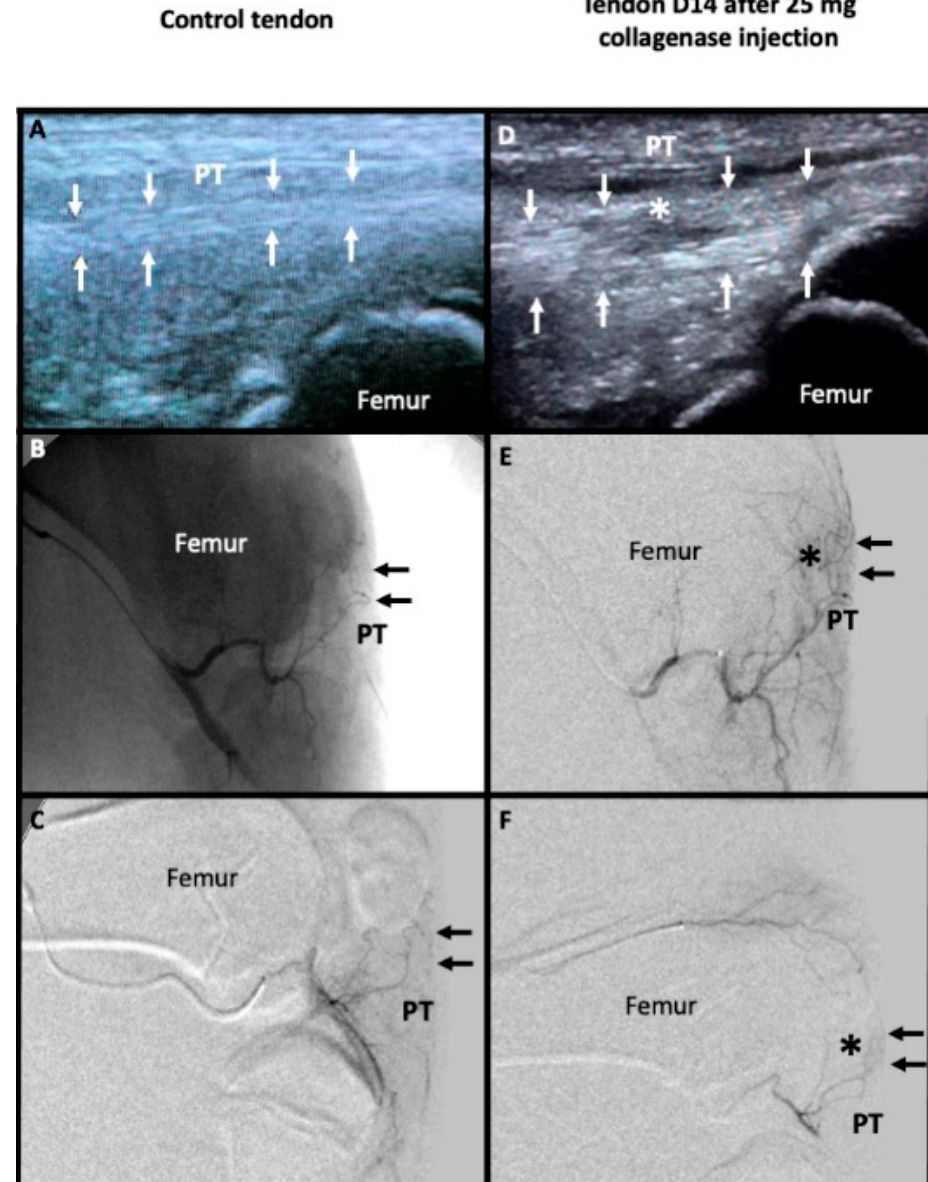
Figure 3. Imaging evaluation between a control tendon (left) and a pathological tendon 14 days after injection of 25 mg of collagenase (right). Sagittal ultrasound acquisition show the regular hyperechoic fibers of the control patellar tendon (PT) framed by small white arrows in ( A ). Microcatheter was placed inside the main genicular artery to perform unsubstracted angiography (without bone substraction which is still visible) in ( B ) and digital substraction angiography showing only the vessels like in ( C ). PT was marked with small black arrows ( B , C , E , F ). There were no abnormal microvessels in projection of PT in the control tendon ( B , C ). The pathological tendon showed a marked thickening framed by small white arrows with hypoechoic change in its mid portion (white asterisk) in ( D ). Angiography in the main genicular artery ( E ) and in the superior genicular artery ( F ) showed abnormal microvessels in projection of PT (black asterisk).